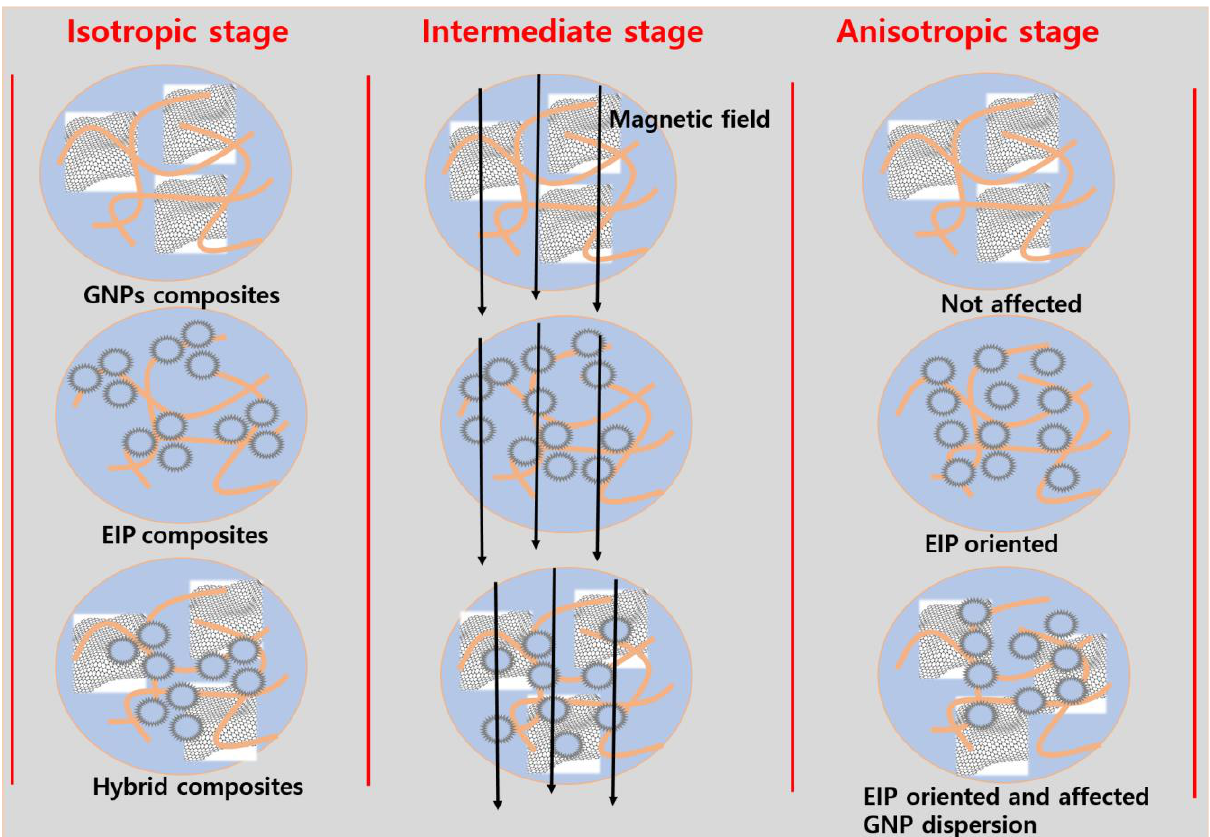
Figure 8. Mechanism of isotropic and anisotropic effects.